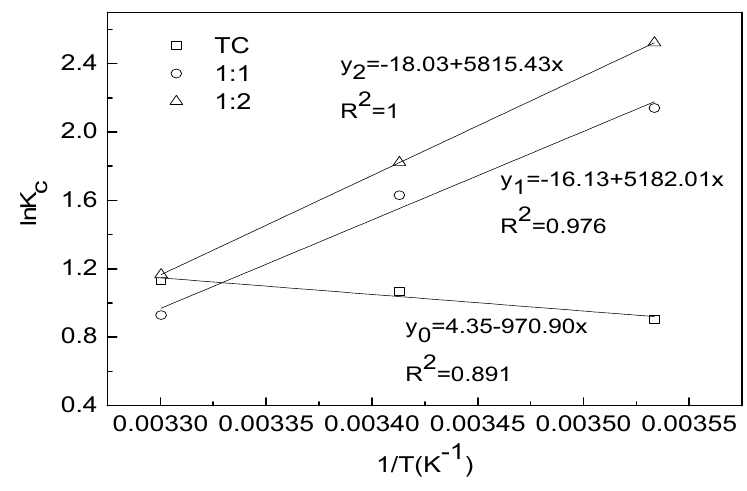
Figure 8. Plots of lnKc versus 1/ T for calculating the activation energy of TC adsorption onto water hyacinth roots. Table 3. Thermodynamics parameters for TC adsorption onto water